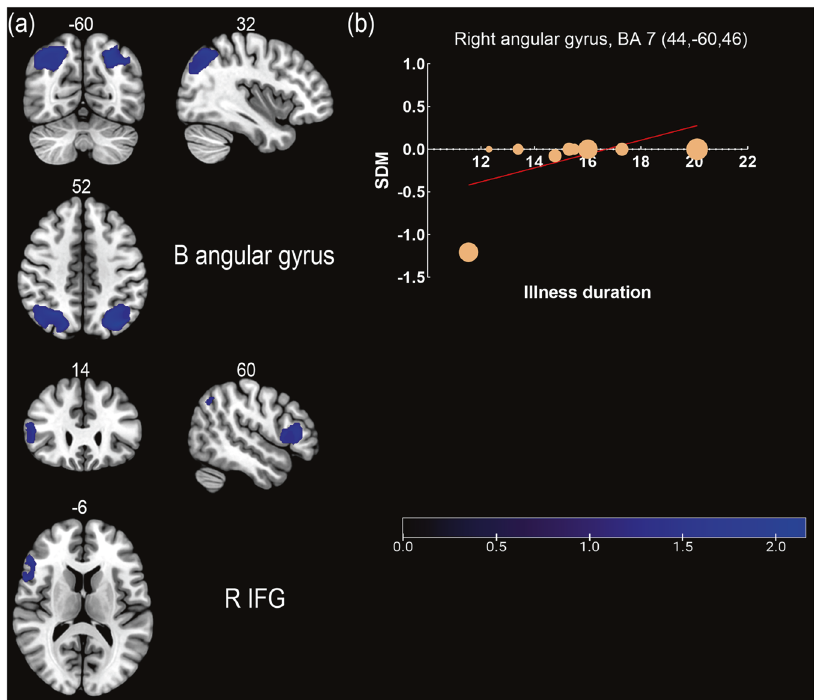
Fig. 2 Results of whole-brain meta-analysis and meta-regression analysis. a Results of meta-analysis showed that BD individuals showed signi fi cant hypoactivation in the bilateral angular gyrus and the right inferior frontal gyrus. b Illness duration of individuals with BD is positively associated with activation of the right angular gyrus. Blue clusters represent hypoactivation in individuals with BD compared to healthy controls. B bilateral, BA brodmann area, IFG inferior frontal gyrus, R right.